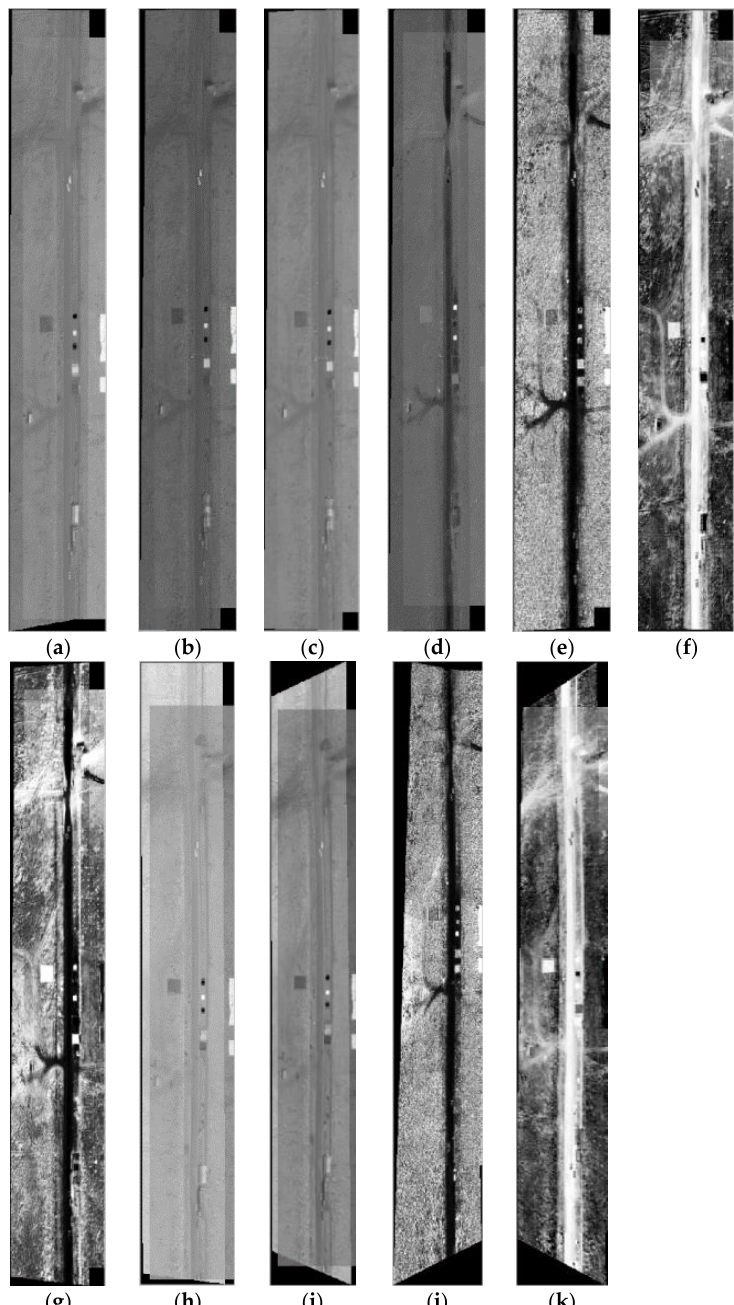
Figure 6. ( a – g ) Resulting mosaic images for the pair LWIR1 a -LWIR1 b for ( a ) brightness temperature,